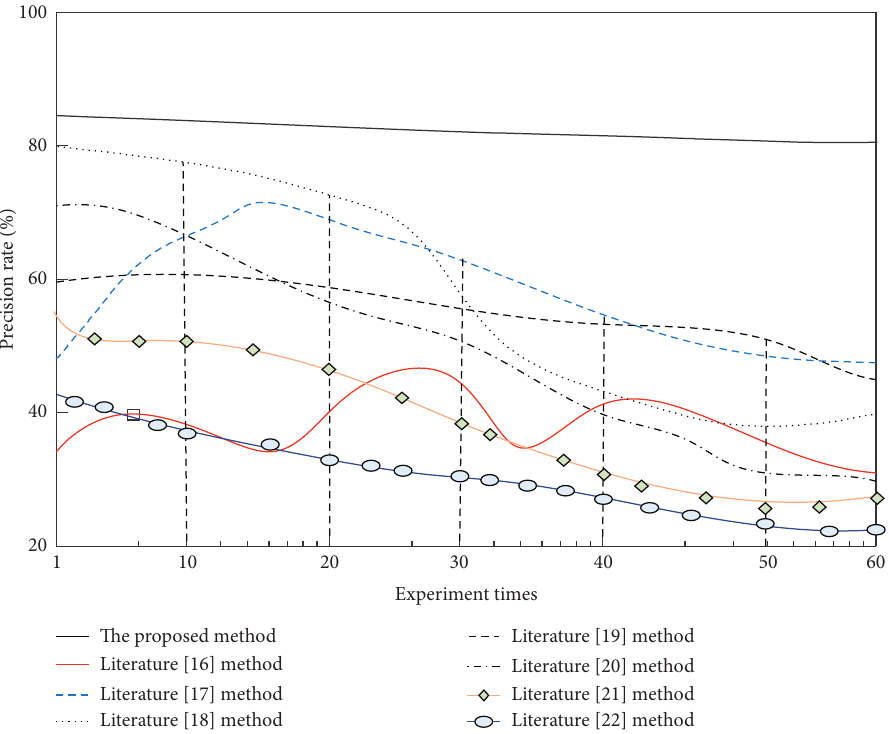
Figure 10: Precision rate